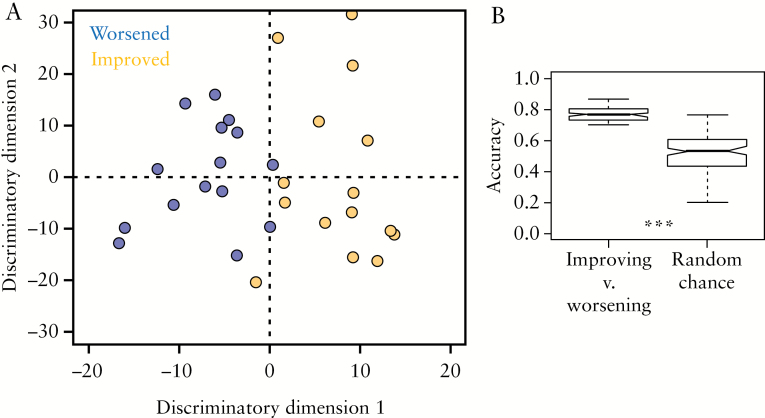
[A] OPLS-DA scores plot discriminating between baseline plasma samples from patients whose UCEIS increased [worsened, blue] or decreased [improved, yellow] over the course of the study. [B] The accuracy of the ensemble of OPLS-DA models is significantly higher than the null distribution, indicating that the discrimination did not occur by chance. Kolmogorov–Smirnov test, ***p < 0.001.